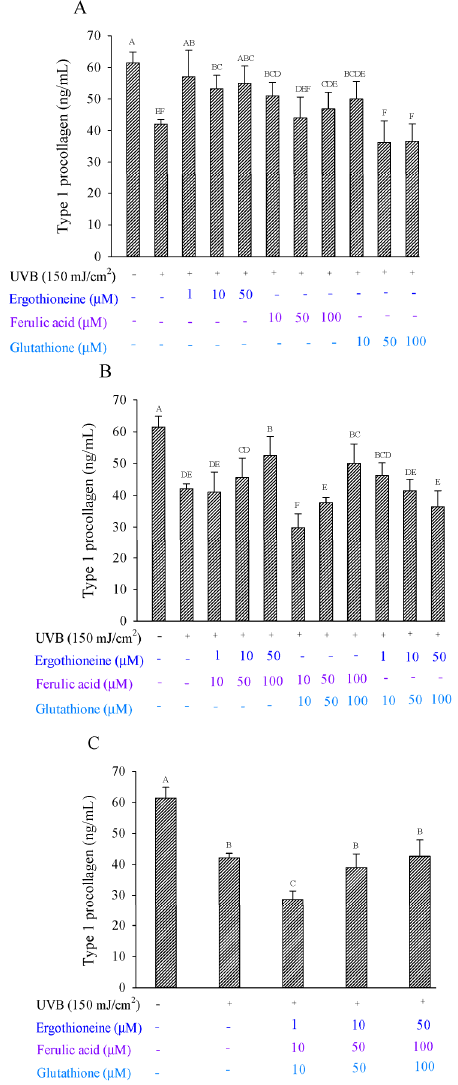
Figure 7. Type 1 procollagen production of Hs68 cells induced by UVB irradiation in the presence of a single ( A ), combination of two ( B ), or combination of three types of antioxidants ( C ), namely ergothioneine, ferulic acid, and glutathione. Each value is expressed as the mean ± SD ( n ≥ 3). Different letters indicate significant differences among treatments ( p < 0.05).